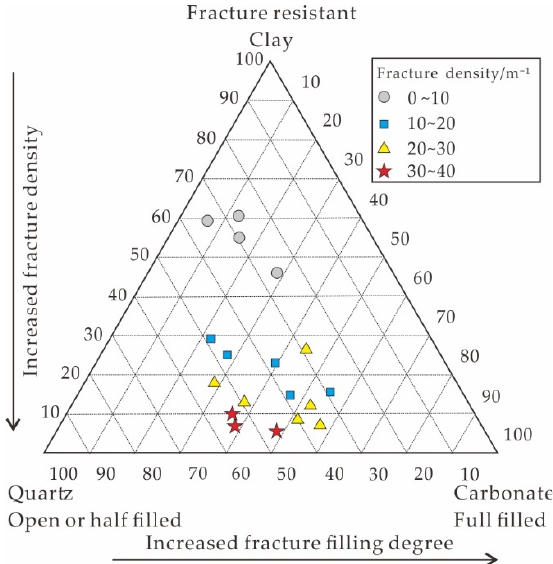
Figure 6. Host rock mineral composition and fracture distribution. Samples were collected from outcrops.